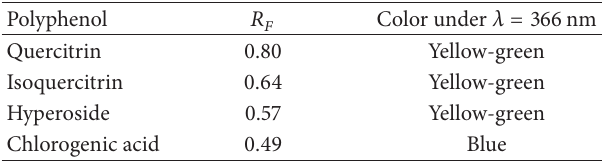
Table 1: Parameters of identification of the polyphenols analyzed.